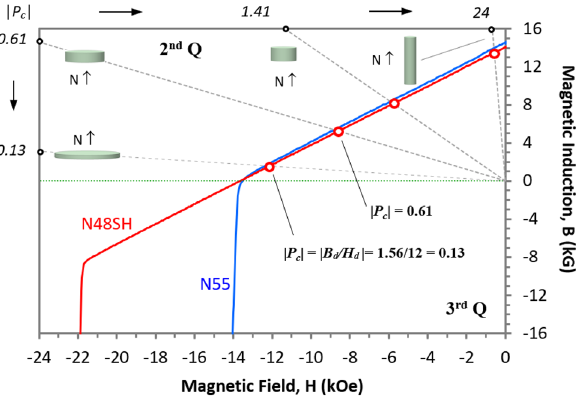
Figure 7. The demagnetization BH curves of N55 and N48SH, and the definition of permeance coefficient P c